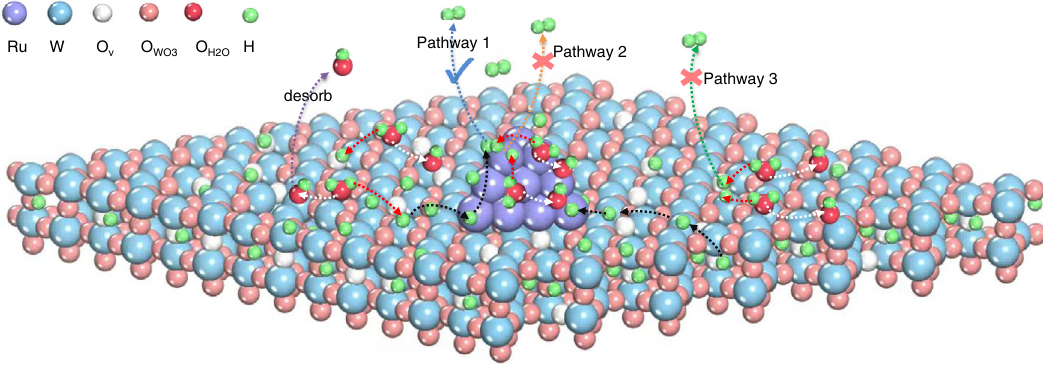
Fig. 6 | Illustration of hydrogen spillover. Schematic diagram showing how hydrogen spillover from WO 3 − x to Ru enhances HER in neutral environment. The white and red arrows indicate the formation process of OH and H from the dis- sociationofwater,respectively.BlackarrowsindicatethetransferprocessofH.The